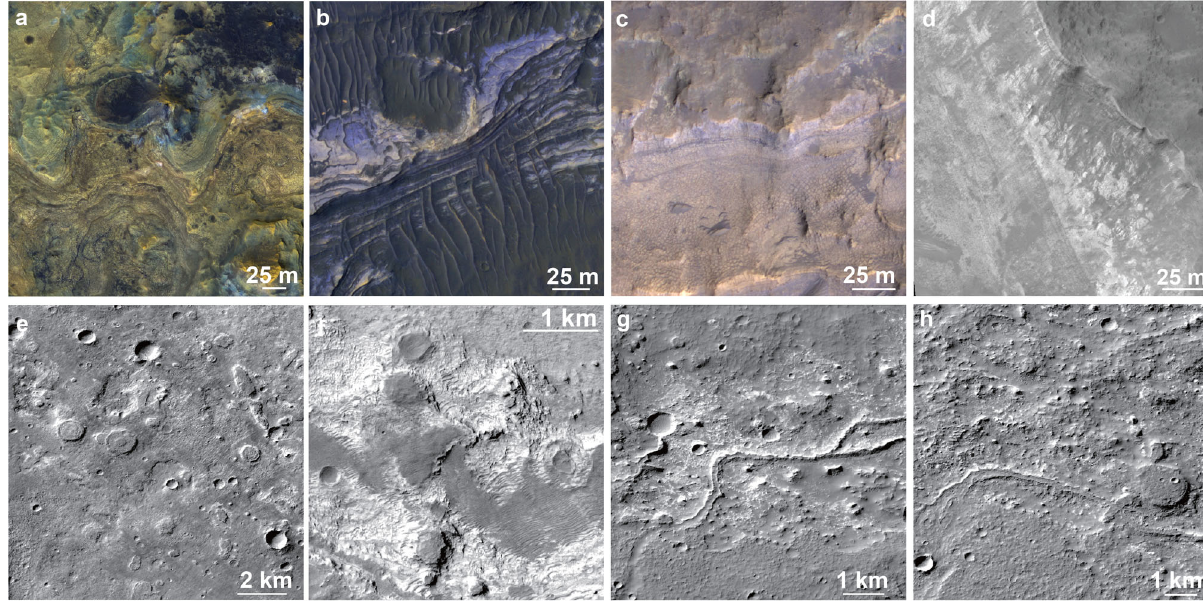
Fig. 9 Evidence of sedimentary process on or within weathering pro fi les on Mars. Layer structures of weathering pro fi les ( a – d ). Inverted craters ( e , f ) and inverted channels on weathering outcrops ( g , h